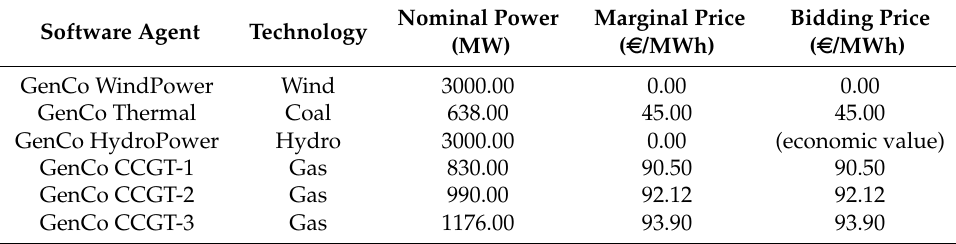
Table 1. Key features of the producer